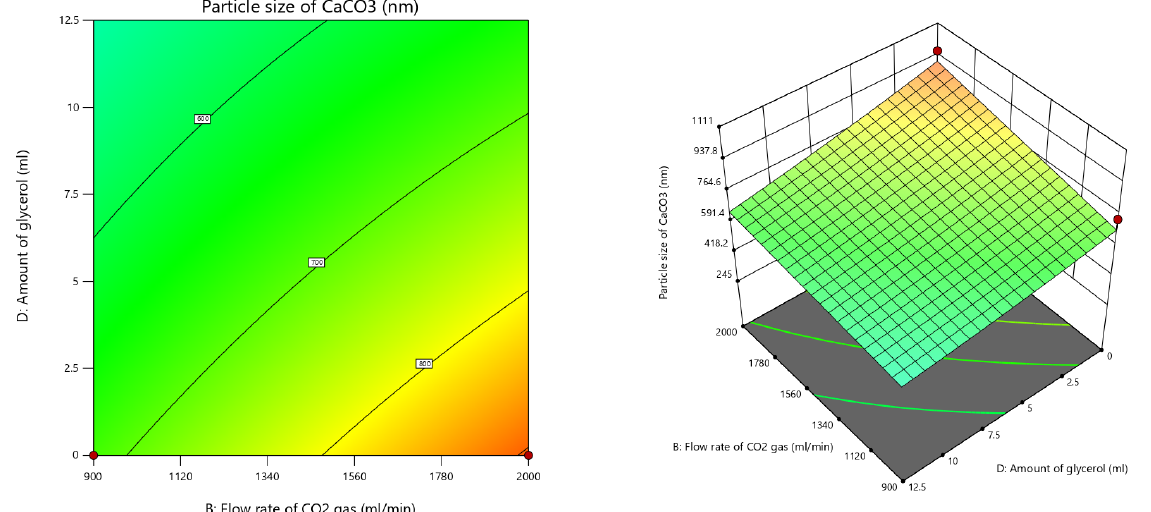
Figure 15. Relationship between the CO 2 flow rate, amount of glycerol, and the particle size of CaCO 3 (Contour and 3D plot).